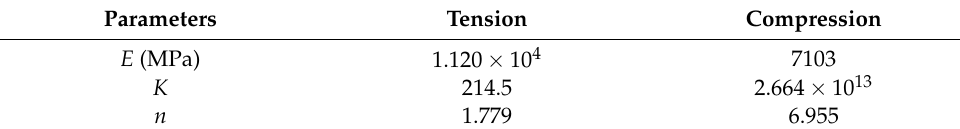
Table 2. Fitting parameters using Equation (2) and testing data of T = − 40 ◦ C.